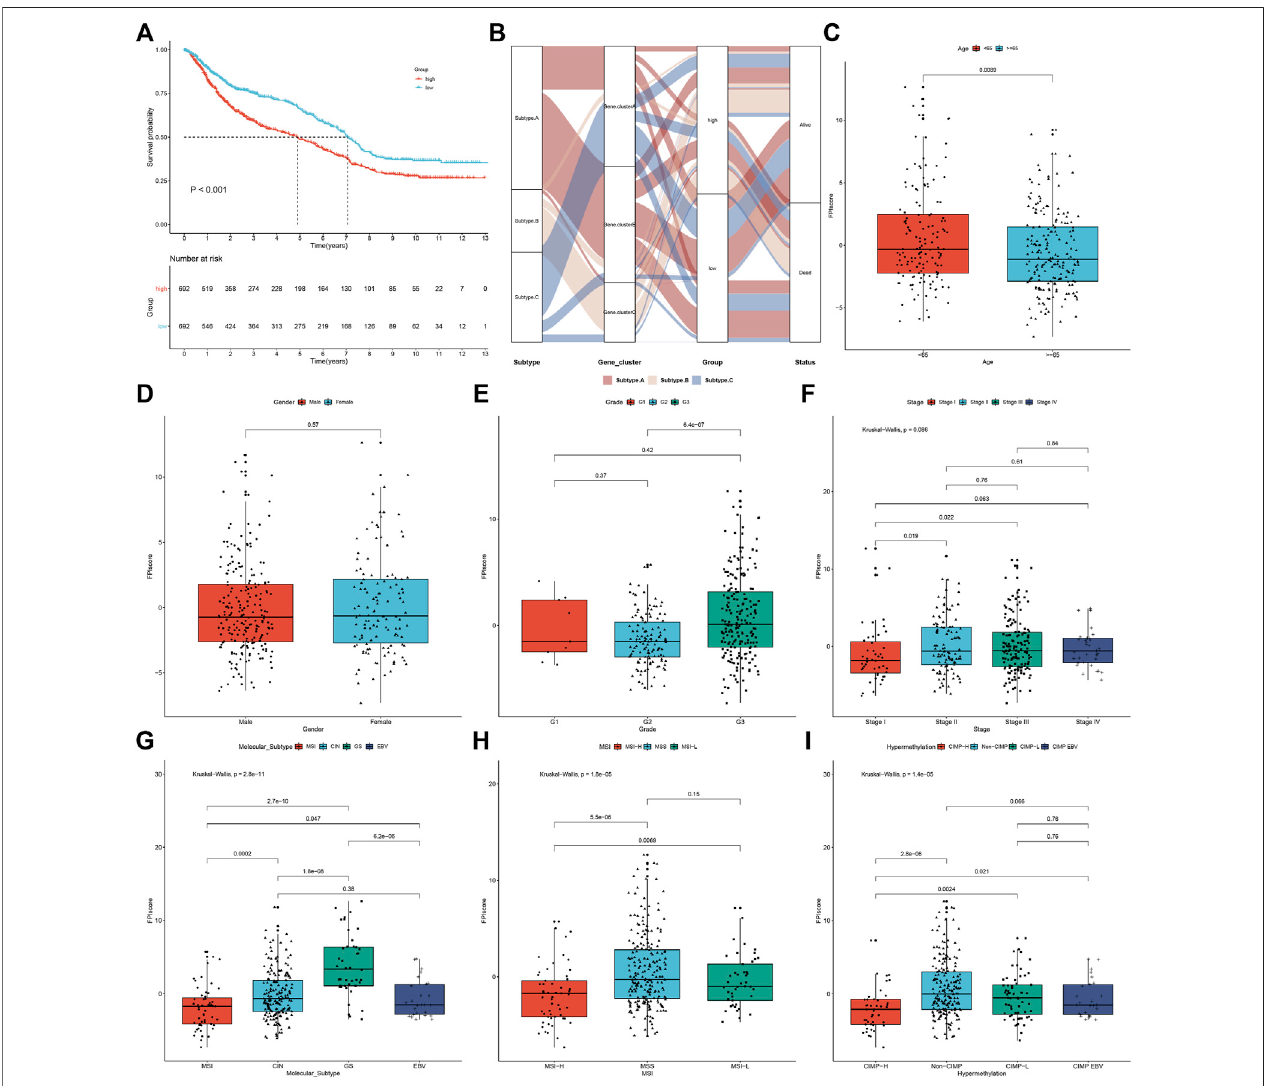
FIGURE 5 | Development of FPI score and evaluation of its relevant clinical features in the meta-cohort. (A) Survival analysis of GC patients in high and low FPI groups. (B) Sankey diagram showing the interactions among ferroptosis subtypes, ferroptosis genomic subtypes, FPI, and survival status. (C – F) Comparison of FPI score in different clinical features, including age (age < 65 years vs. age ≥ 65 years), gender (female vs. male), grade (G1 vs. G2 vs. G3), and stage (stage I vs. stage II vs. stage III vs. stage IV). (G – I) Comparison of the FPI score in different subtypes, including molecular subtypes (MSI, CIN, GS, and EBV), MSI status-based subtypes (MSI-H, MSS, and MSI-L), and DNA methylation-based subtypes (CIMP-H, CIMP-L, CIMP-EBV, and non-CIMP).